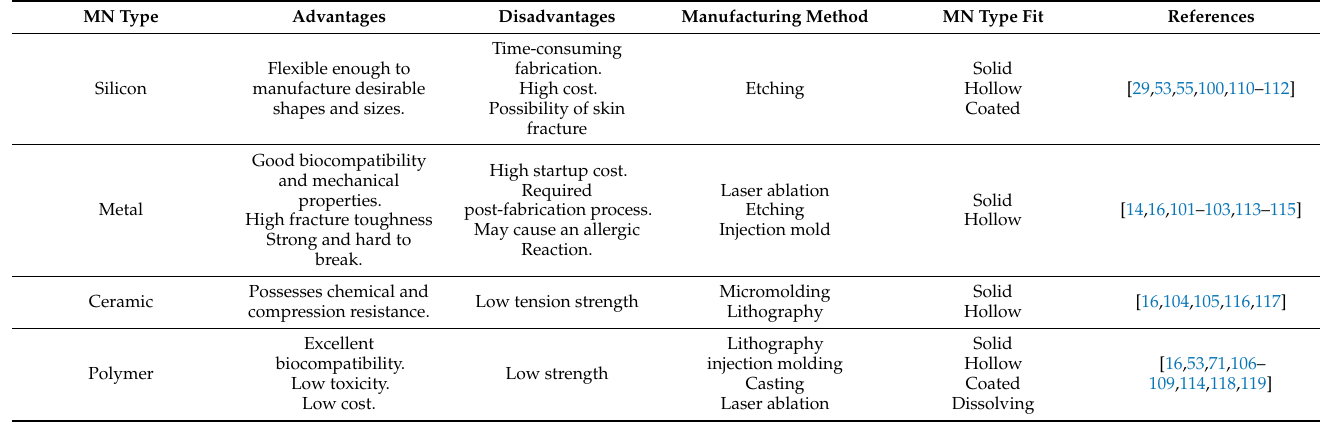
Table 2. Overview: MN Materials.